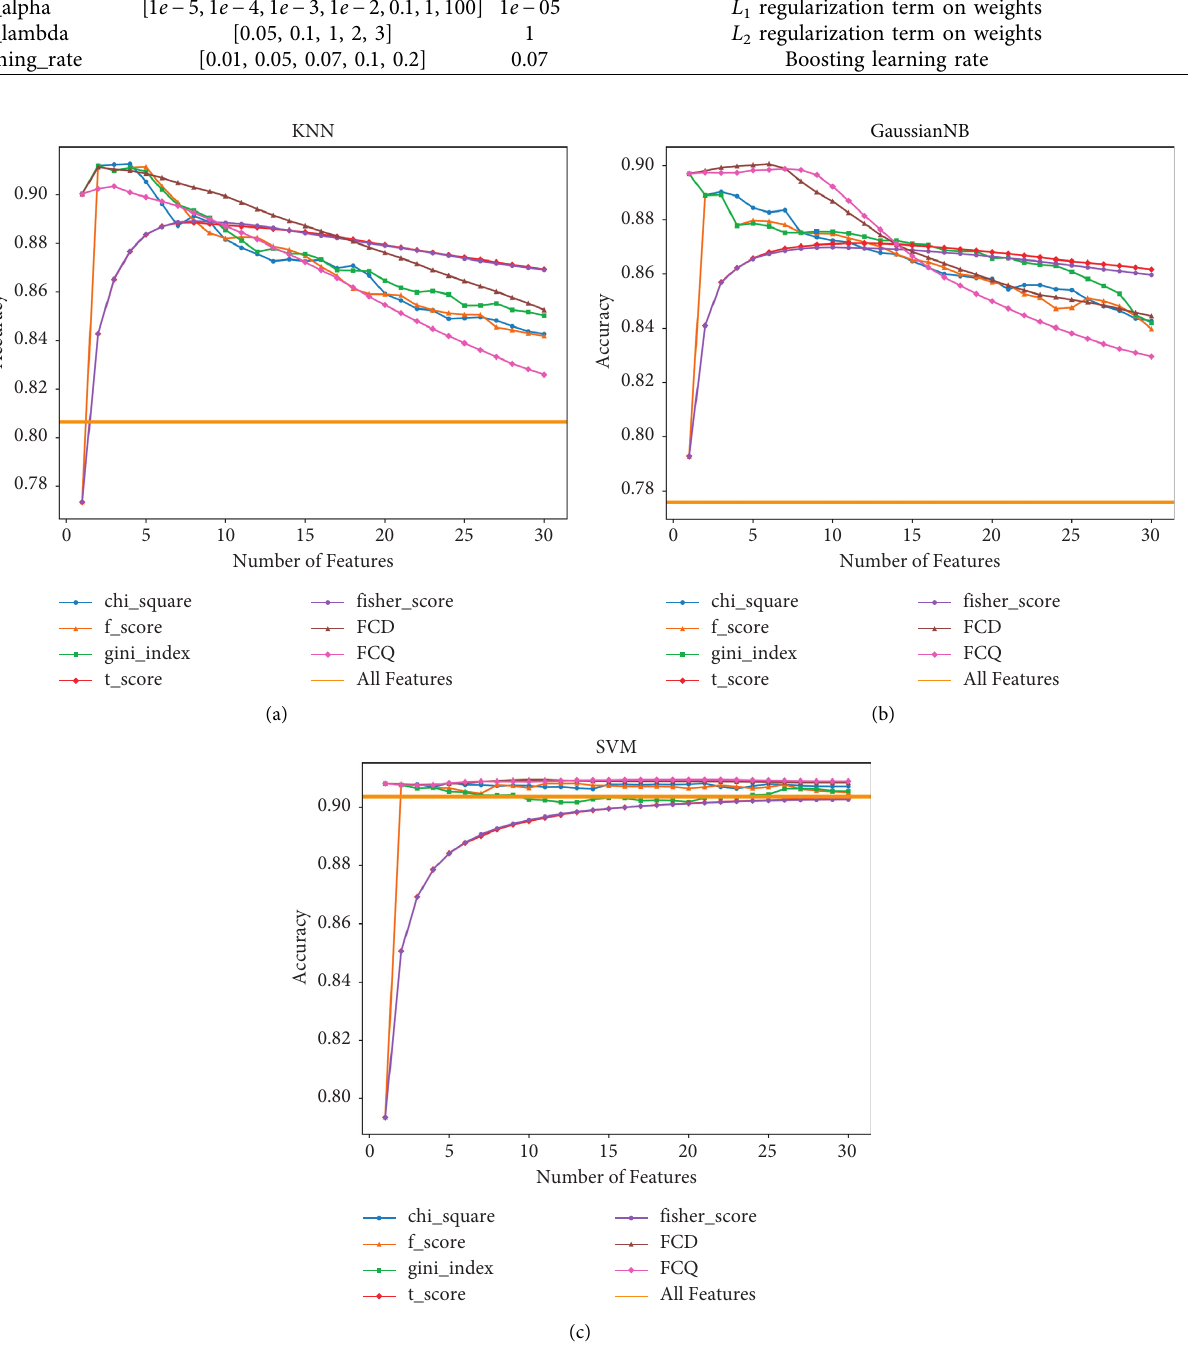
Figure 4: Accuracy of different filter feature selection methods in three classification